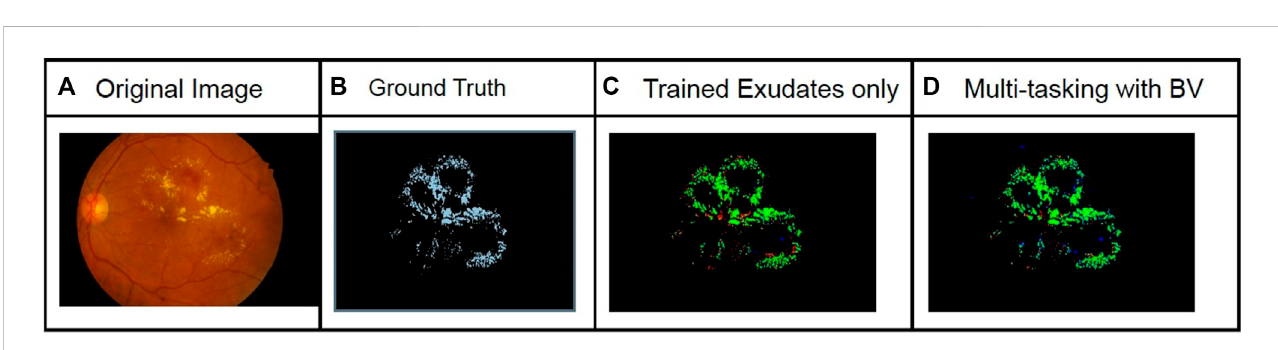
FIGURE 8 Comparison of exudates segmentation results for the IDRiD dataset with and without multi-tasking. The green pixels in the predicted image correspond to true positives, blue pixels correspond to false positives, and red pixels correspond to false negatives. An increase in F1 score of 15% was observed. The columns from left to right show original image (A) , Ground Truth (B) , Prediction with model trained only for Exudates segmentation (C) and Prediction using model trained with Exudates and BV segmentation (D) .